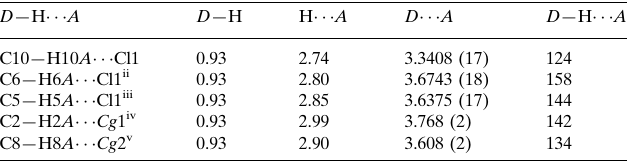
Hydrogen-bond geometry (A˚ , (cid:4)